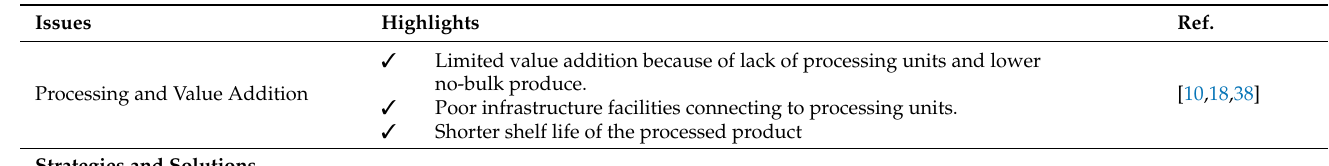
Table 9. Accumulated post-harvest problems in the value chain of kiwi in Bageshwar District and strategies and solutions